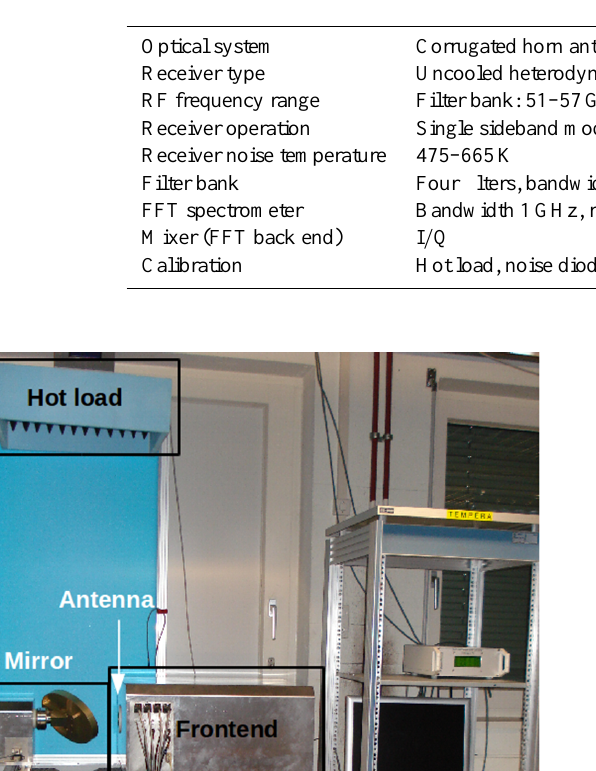
Table 1. Specifications of TEMPERA.